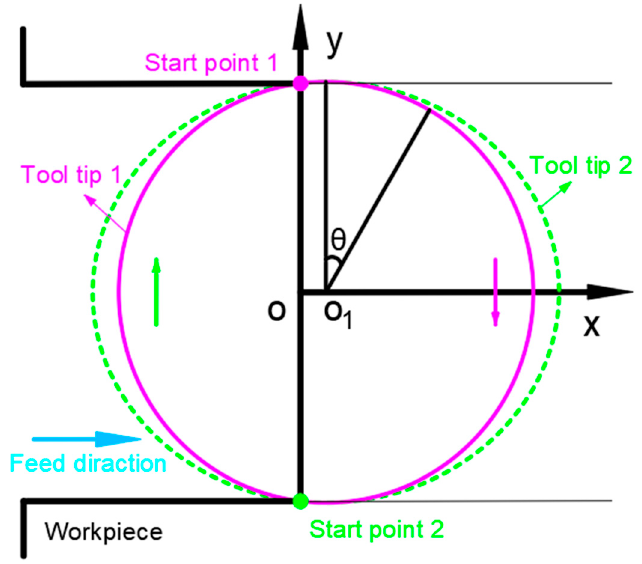
Figure 4. Schematic diagram of tool tip path.